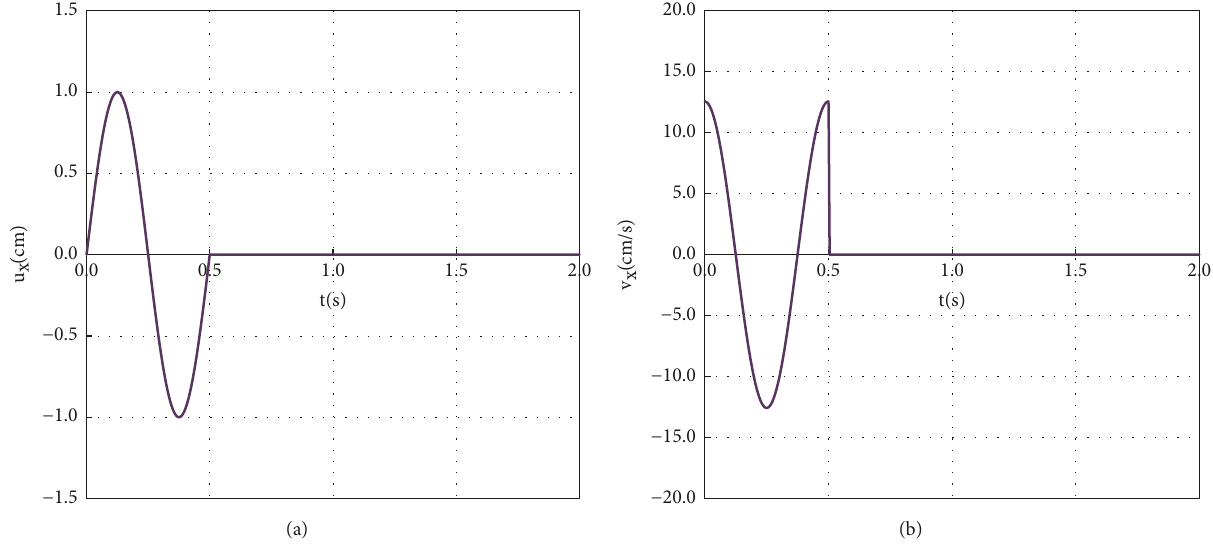
Figure 7: Time histories of horizontal design ground motion: (a) displacement and (b) velocity.